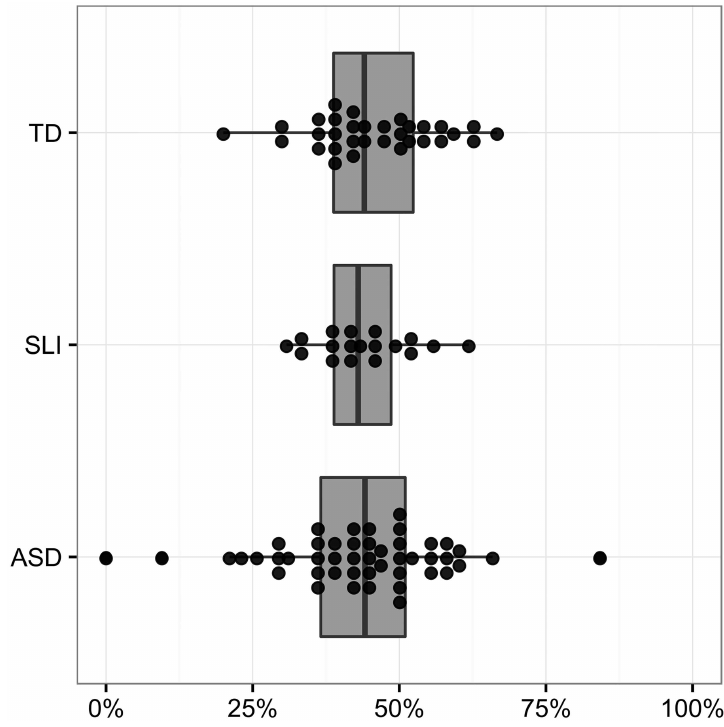
Fig 3. Percent of content mazeswhich are false starts (versusrepetitions and revisions).